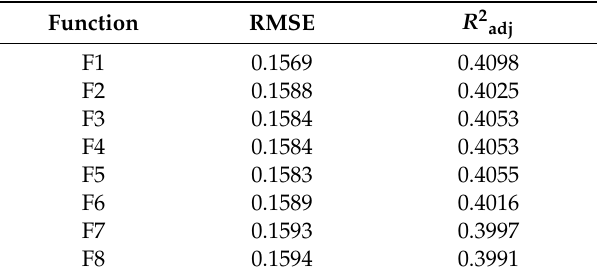
Table 4. Fit statistics of the base functions fitted to diameter increment data. All functions are defined in Table 3.